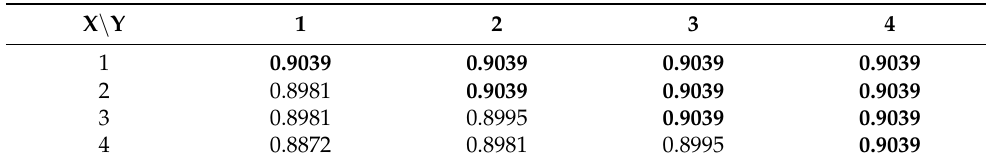
Table 3. Experimental results with the weighted parameters, with the bold represents the best experimental results.